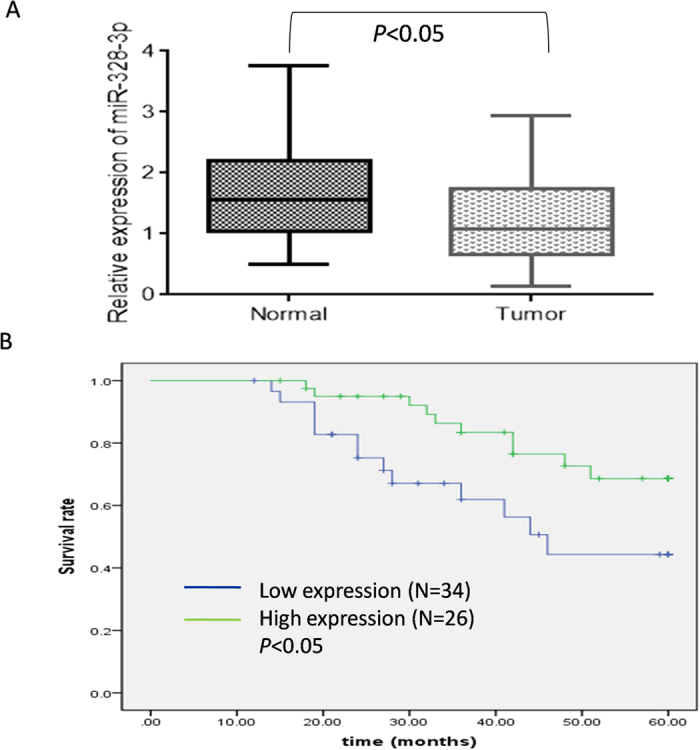
Comparison of miRNA expression profiles in NSCLC and paired normal tissues.(A) miR-328-3p expression level was significantly lowered in NSCLC tissues compared to the adjacent non-cancerous tissues. U6 was used as an internal control. *p < 0.05. (B) Shortly, overall survival time was observed in patients with a low miR-328-3p expression compared to a higher miR-328-3p expression patients as shown by the Kaplan-Meier survival curve (p < 0.05).